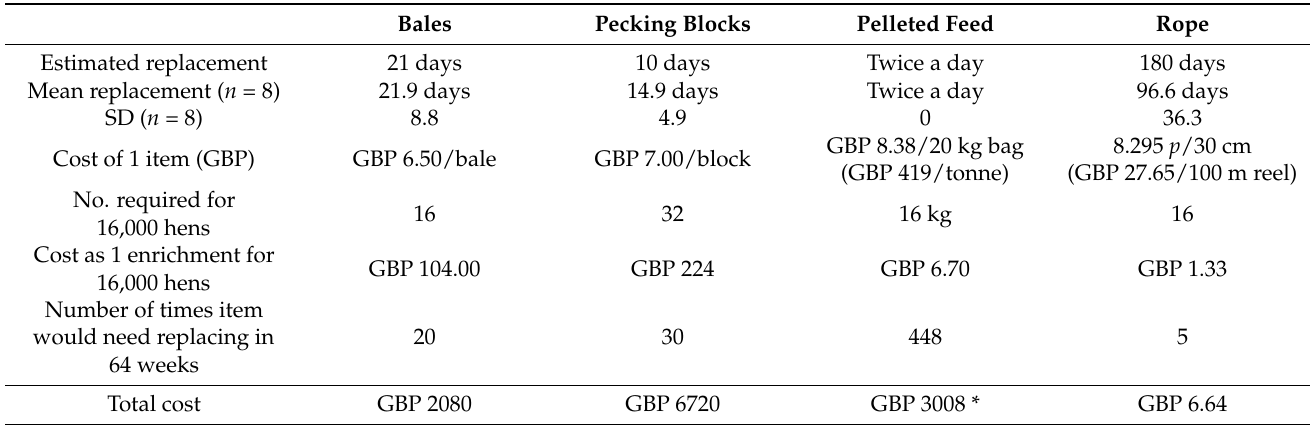
Table 7. The estimated and actual mean rate of replacement for the four enrichments in eight flocks, with standard deviation (SD) given, and the total cost of using each enrichment in a flock of 16,000 hens, housed for 64 weeks (16–80 weeks of age), based on the actual mean rate of replacement seen here. Costs do not include local taxes or shipping. Bales Pecking Blocks Pelleted Feed